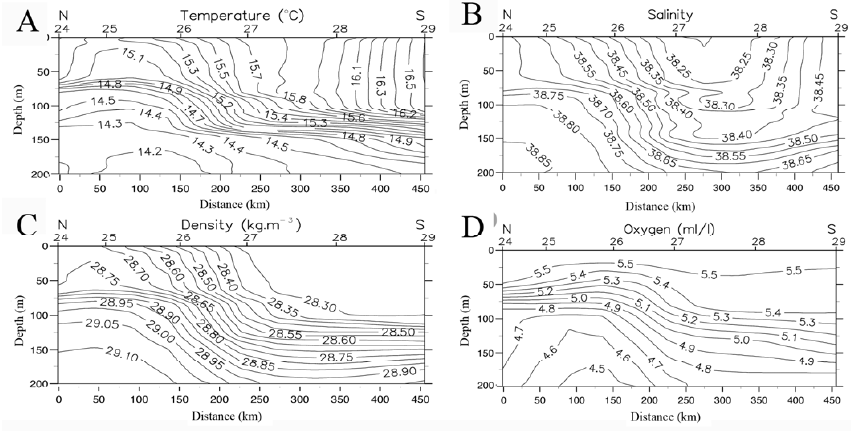
Fig. 6. Vertical distribution of (A) temperature, (B) salinity, (C) density and (D) dissolved oxygen along the north-south transect defined by stations 24 to 29. To note, the presence of an eddy field establishing a thermohaline front located between stations 25 and 27.